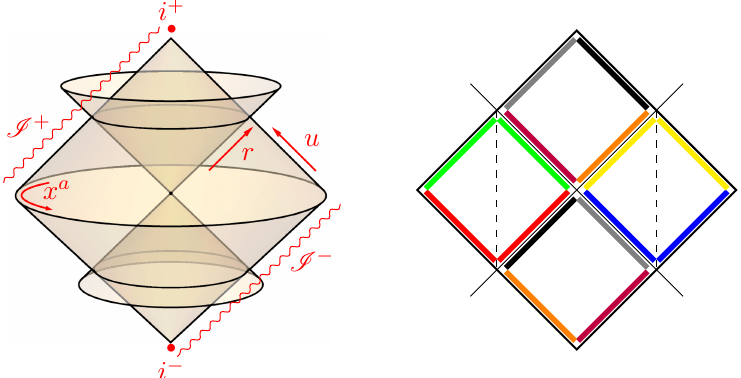
Figure 1. Left: A Penrose diagram of Minkowski spacetime, displaying Bondi coordinates ( r, u, x a ) , d , along with the past and future light-cones of the origin. Each circle is really with a = 1 , · · · a sphere S d . The conformal boundary of the diagram consists of future and past null infinities, respectively denoted I + and I − . Right: The past and future light-cones of the origin are related x µ /x 2 , written here in inertial coordinates. Any two segments to null infinities by an inversion x µ → of the same colour are mapped on one another under this map, and the two dashed lines indicate its fixed points. See footnote 8 for a more detailed